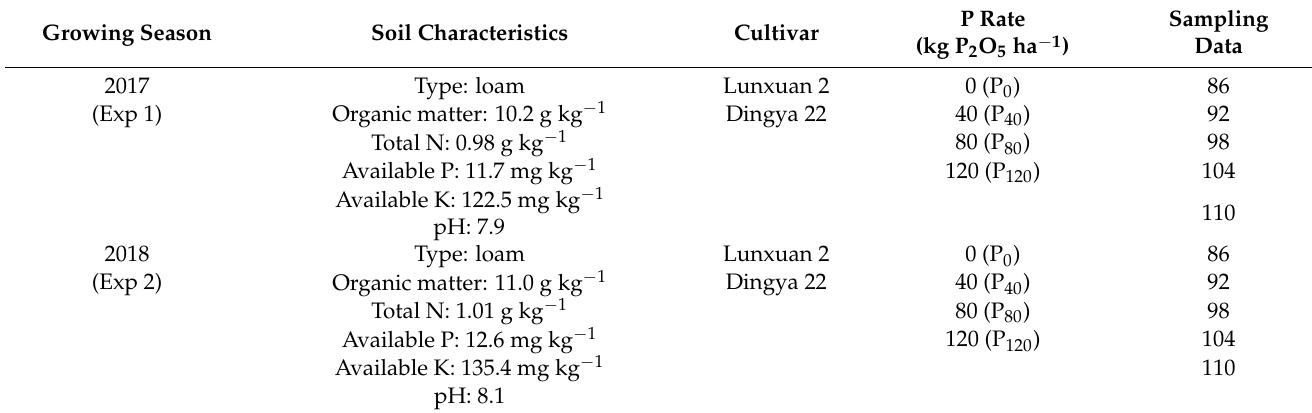
Table 1. Basic information at the Dingxi site in the 2017 and 2018 growing seasons. Growing Season Soil Characteristics